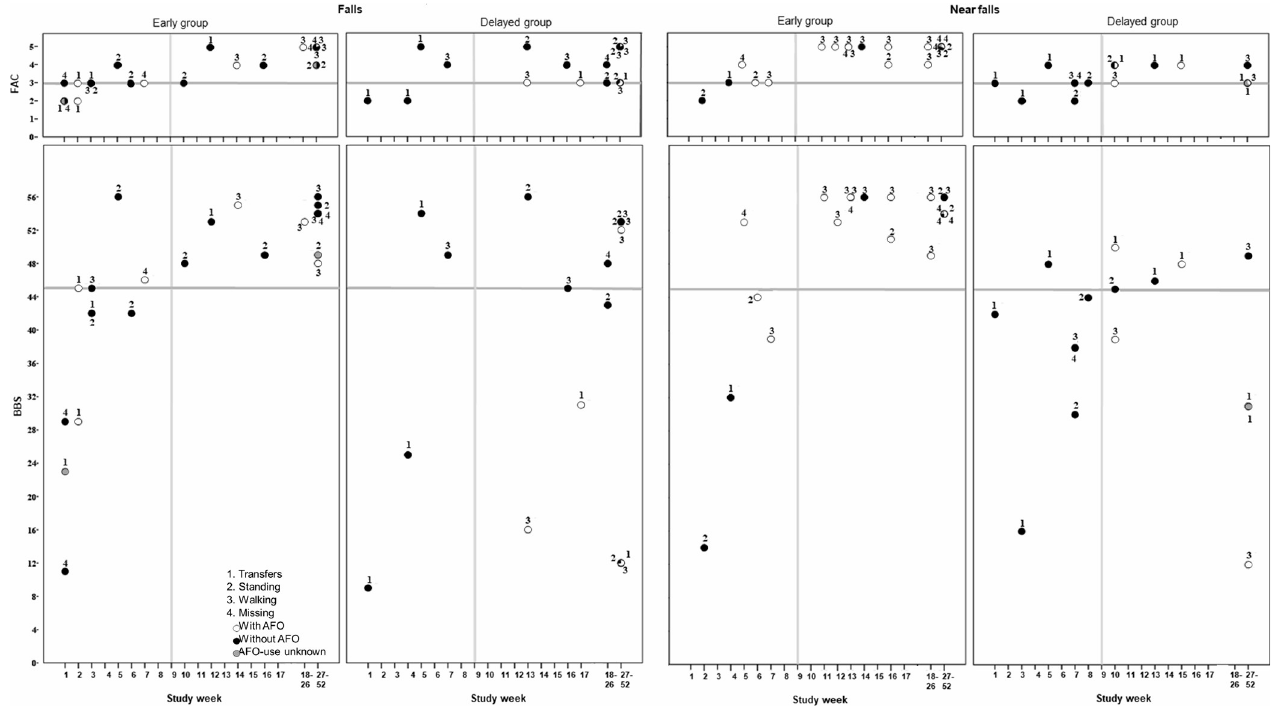
Fig 2. Functional Ambulation Categories (FAC) and Berg Balance Scale (BBS) scores related to falls and near falls in the early and delayed group. The position of the circle represents the BBS- or FAC-score at the time of the incident. The colour of the circle represents whether the AFO was used at the time of the incident. The numbers around the circles represent the activities performed during the incident. The vertical grey lines represent study week 9 (before week 9 the delayed group had not use an AFO), the horizontal grey lines indicate FAC-scores of 3 and BBS-scores of 45.